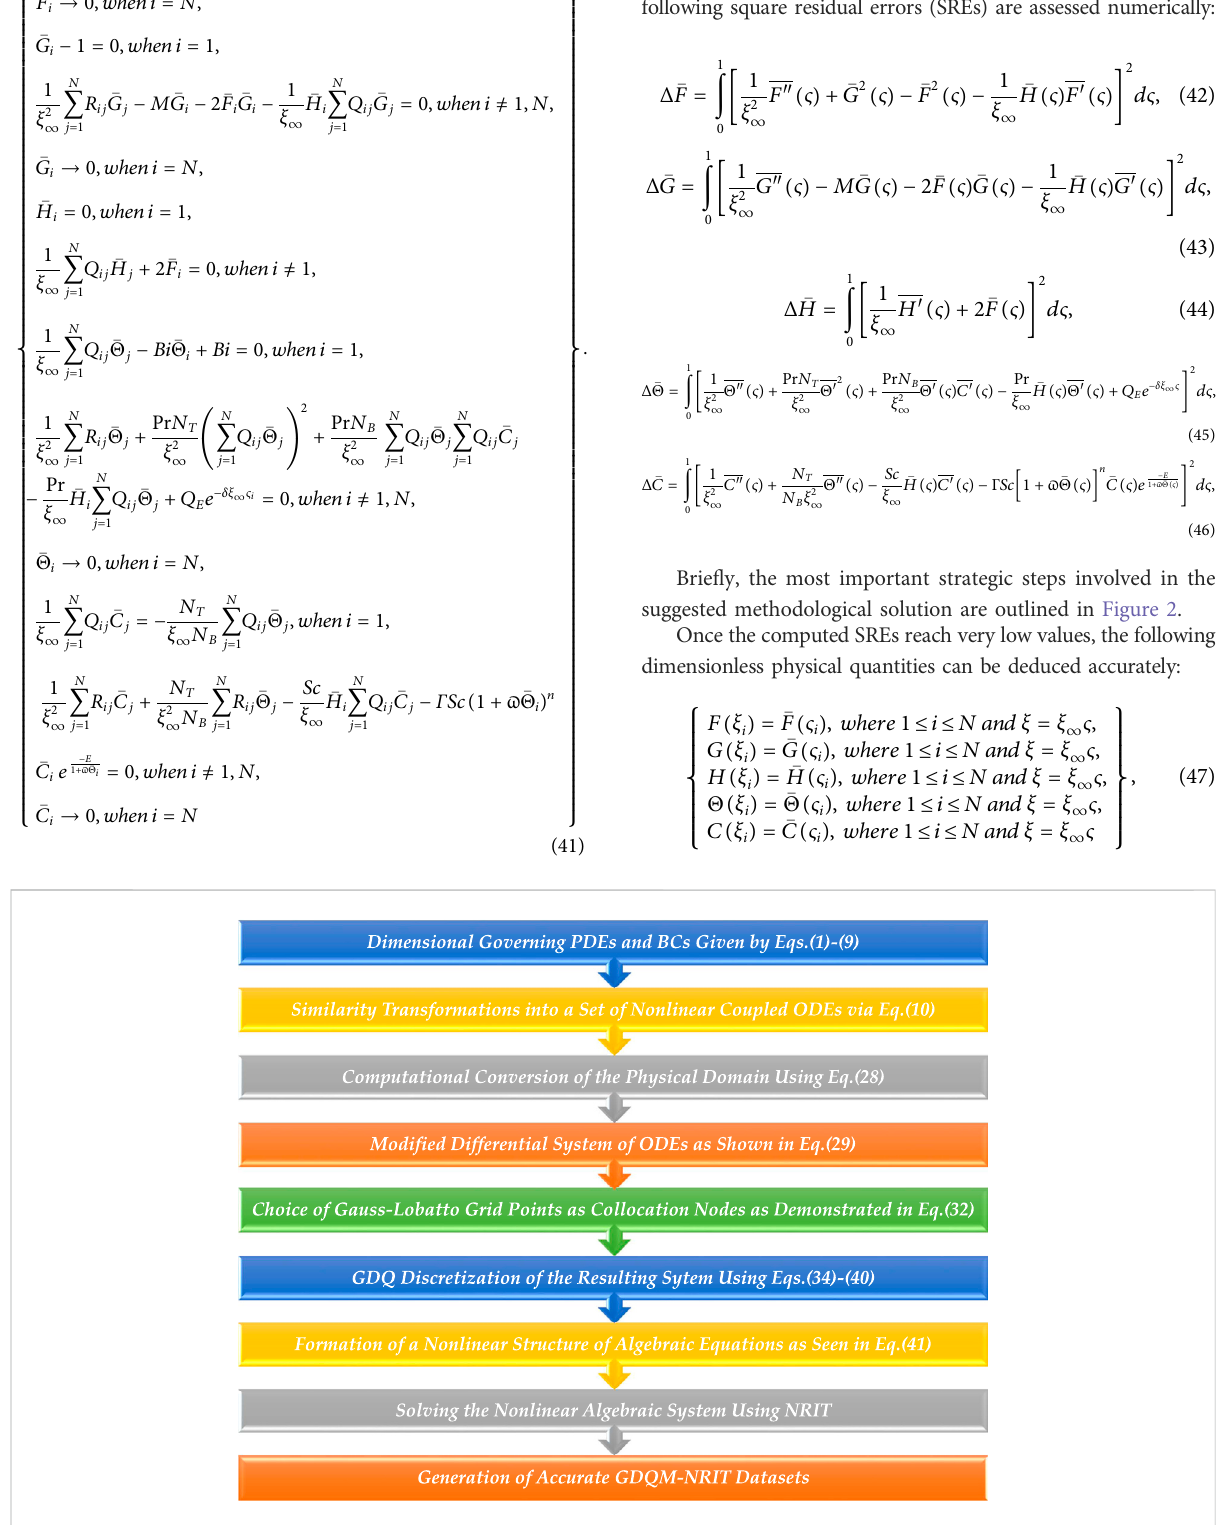
FIGURE 2 Detailed fl owchart of the employed solution